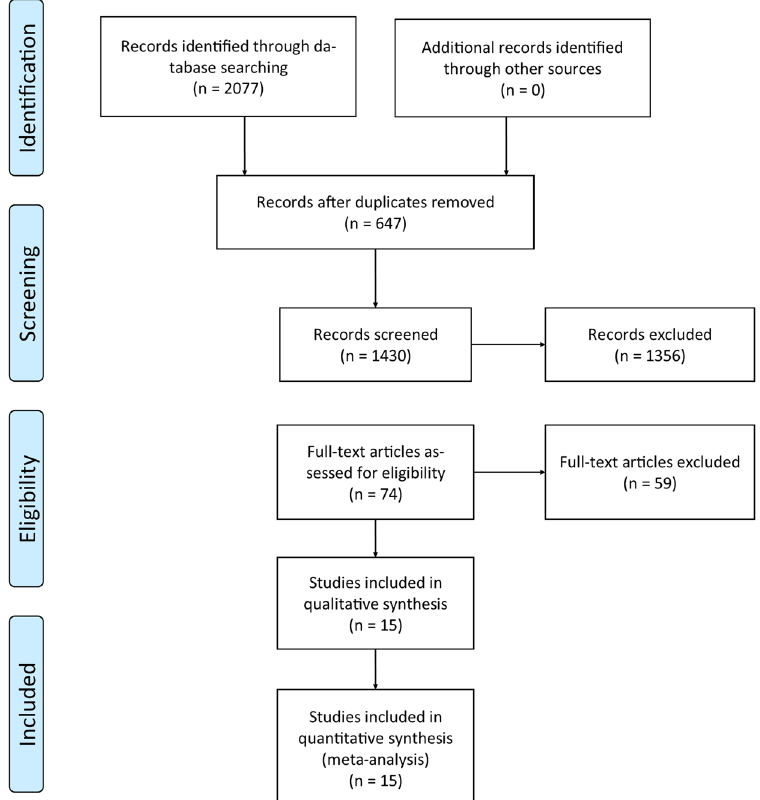
Figure 1. PRISMA flowchart of study selection. The systematic review and meta-analysis was conducted according to the guidelines recommended by PRISMA 48